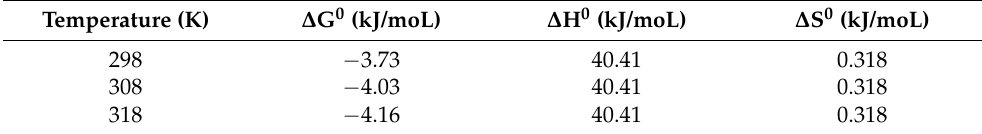
Table 3. Parameters of thermodynamic for the adsorption of As(V) by Fe 3 O 4 @ZIF-8. Temperature